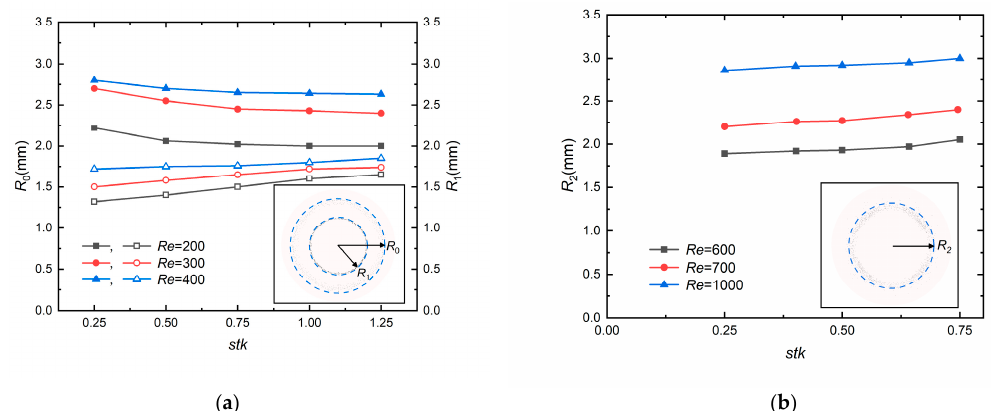
Figure 9. The radius of the ( a ) “halo” and ( b ) “ring” changes in terms of the different Re and stk . R 0 and R 1 are expressed as the radius of halo and primary deposit, respectively. R 2 is expressed as the radius of ring. The solid points denote R 0 , and hollow points denote R 1 in Figure 9a.